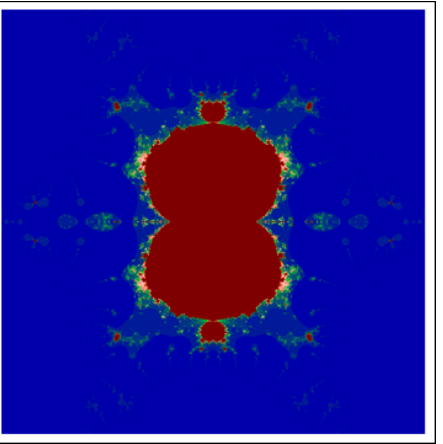
Figure 37. M-set in F-orbit for sin ( z 3 ) + c with image visualization time =